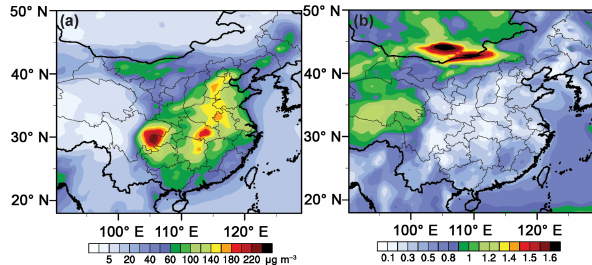
Figure 11. The ensemble mean monthly averaged near-surface dis- tributions of PM 2 . 5 for January 2010 (a) , along with the spatial dis- tribution of the coefficient of variation ( b , SD divided by the aver-